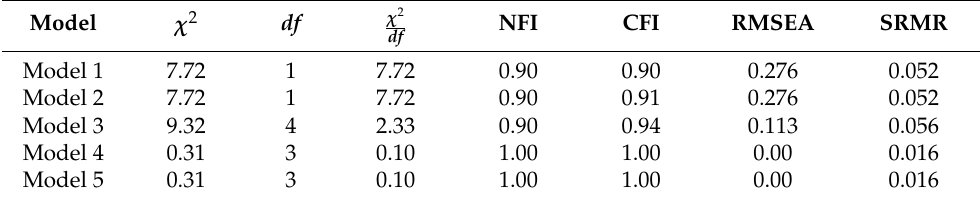
Table 4. Goodness-of-fit metrics from all models fit on